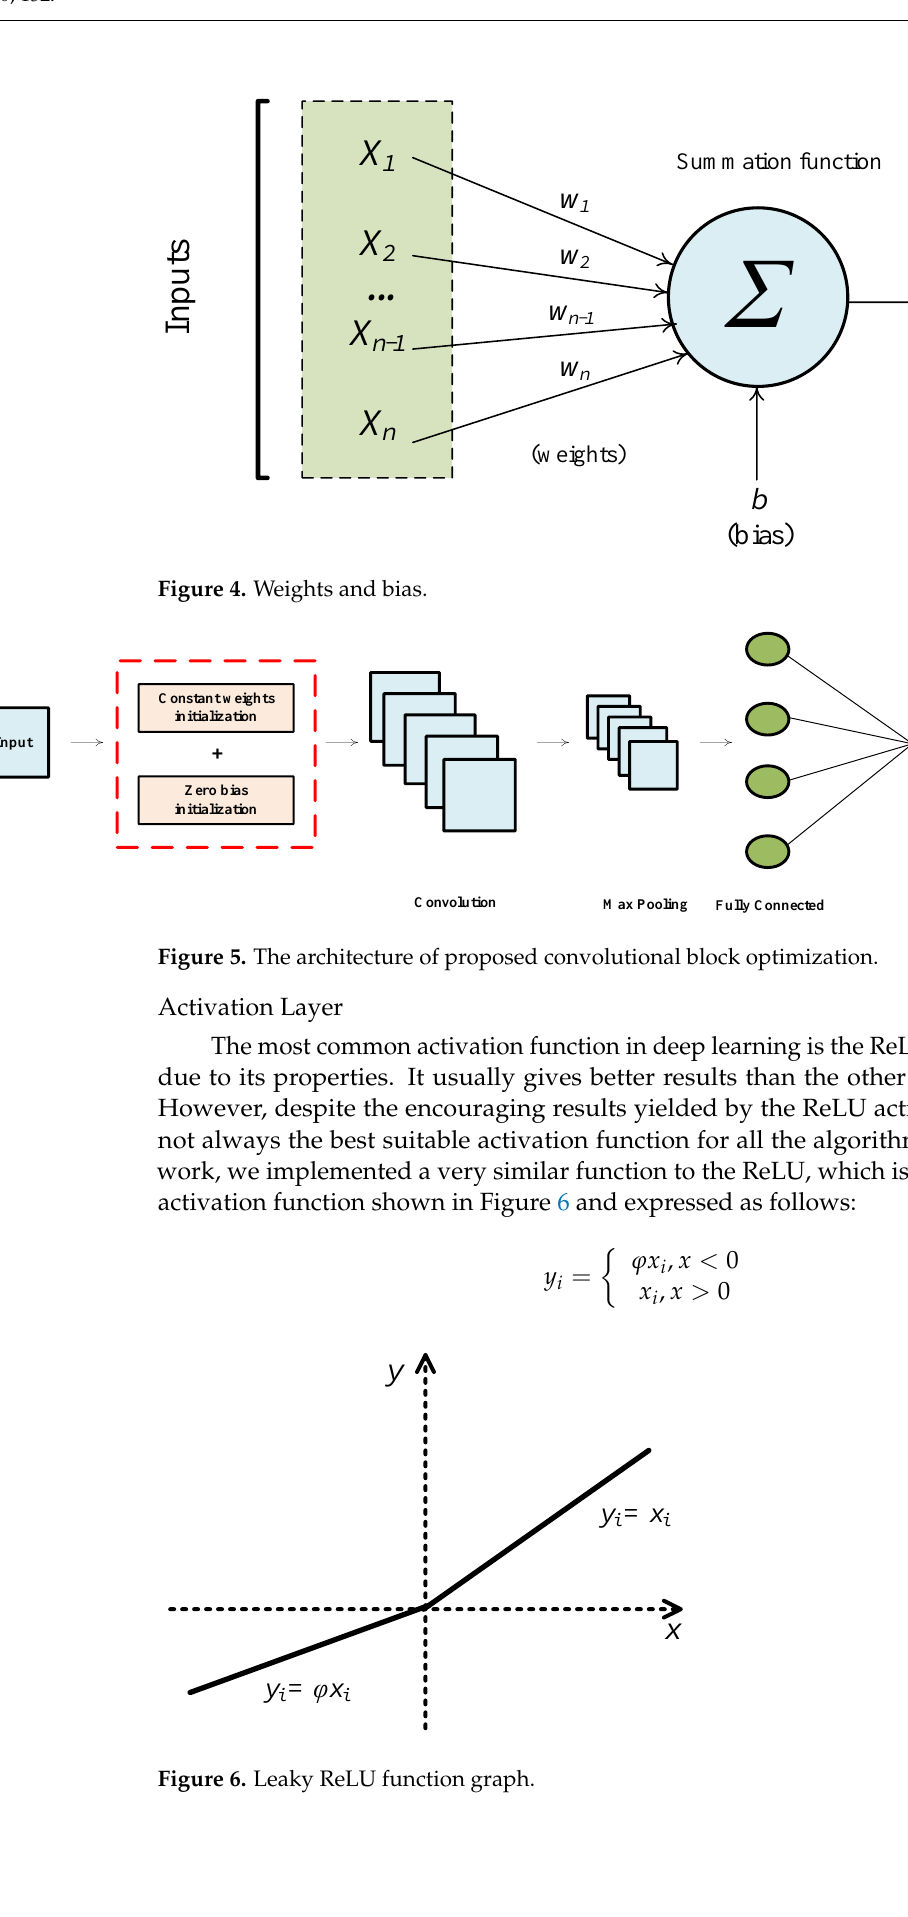
Figure 6. Leaky ReLU function graph.